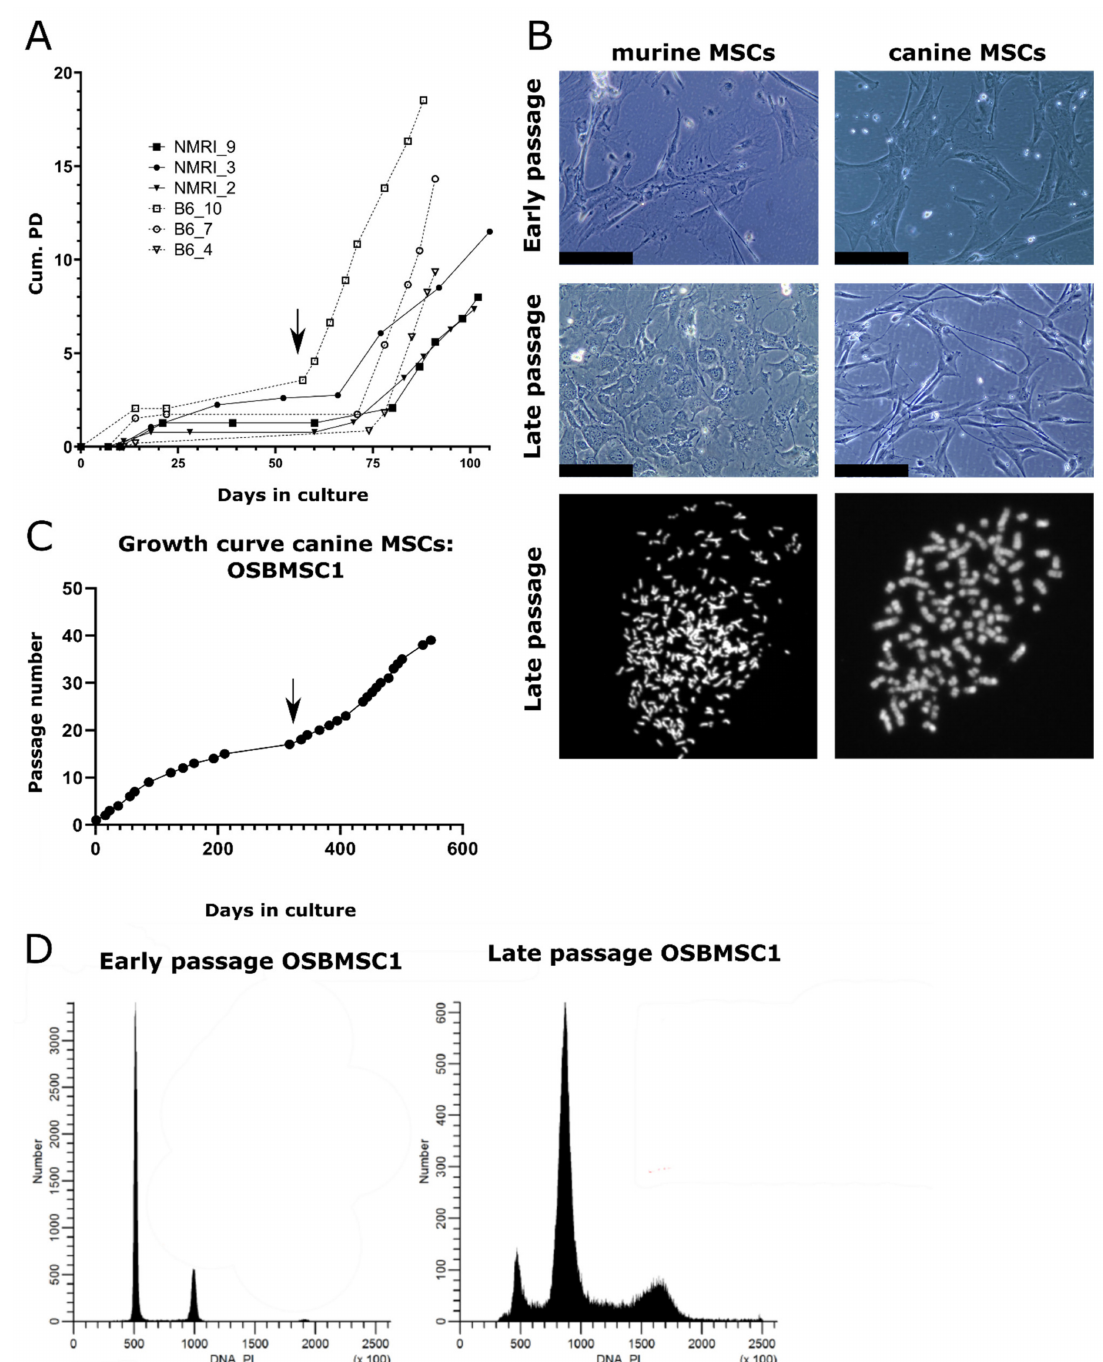
Figure 1. Mesenchymal stem cells (MSCs) from dogs and mice transform spontaneously after long-term culture. ( A ) MSCs isolated from NMRI or C57BL/6J mice undergo spontaneous transformation after long-term in vitro culture based on cumulative population doubling (Cum. PD). Example of transformation event in B6_10 is indicated by an arrow. ( B ) Repre- sentative images of murine and canine MSCs. Late passage murine MSCs show a higher nuclear to cytoplasm ratio, as evident from the nuclear enlargement, compared to early passage MSCs. Scalebar represents 100 µ m. Karyotyping showed late passage MSCs have an increased number of chromosomes per cell after DAPI staining, as murine and canine cells normally have 40 or 78 chromosomes, respectively. ( C ) MSCs isolated from a 7-year-old Rottweiler transform spontaneously after long-term ex vivo culture (OSBMSC1), indicated with an arrow, at each data point, cells were trypsinized and passaged. ( D ) DNA content analysis by flow cytometry shows that late passage canine MSCs OSBMSC1 have become